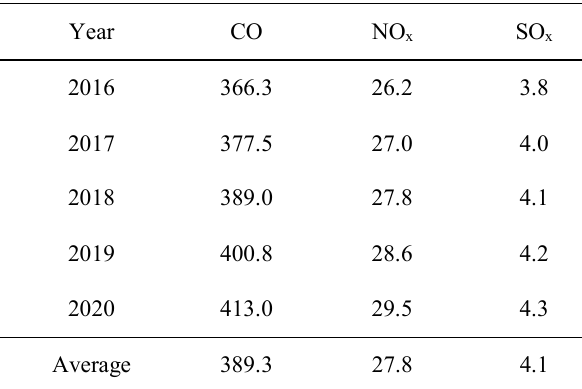
Table 2. Total average emissions (g/s).